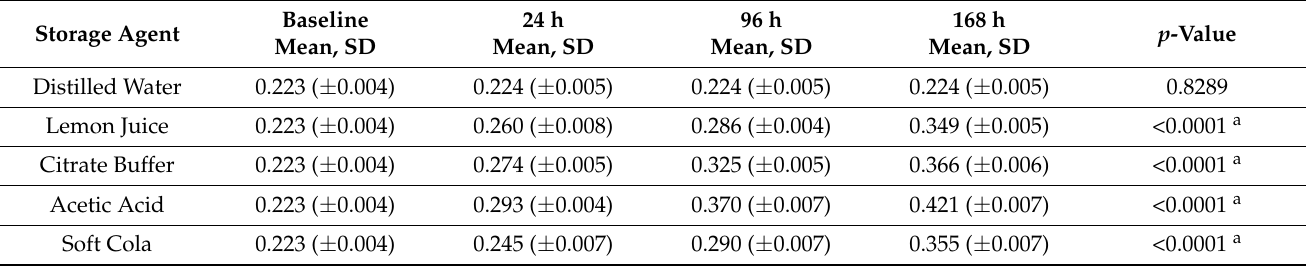
Table 3. Comparison of surface roughness (mean Ra value) of nano-fluorapatite ceramic across four different time intervals for each immersion solution.